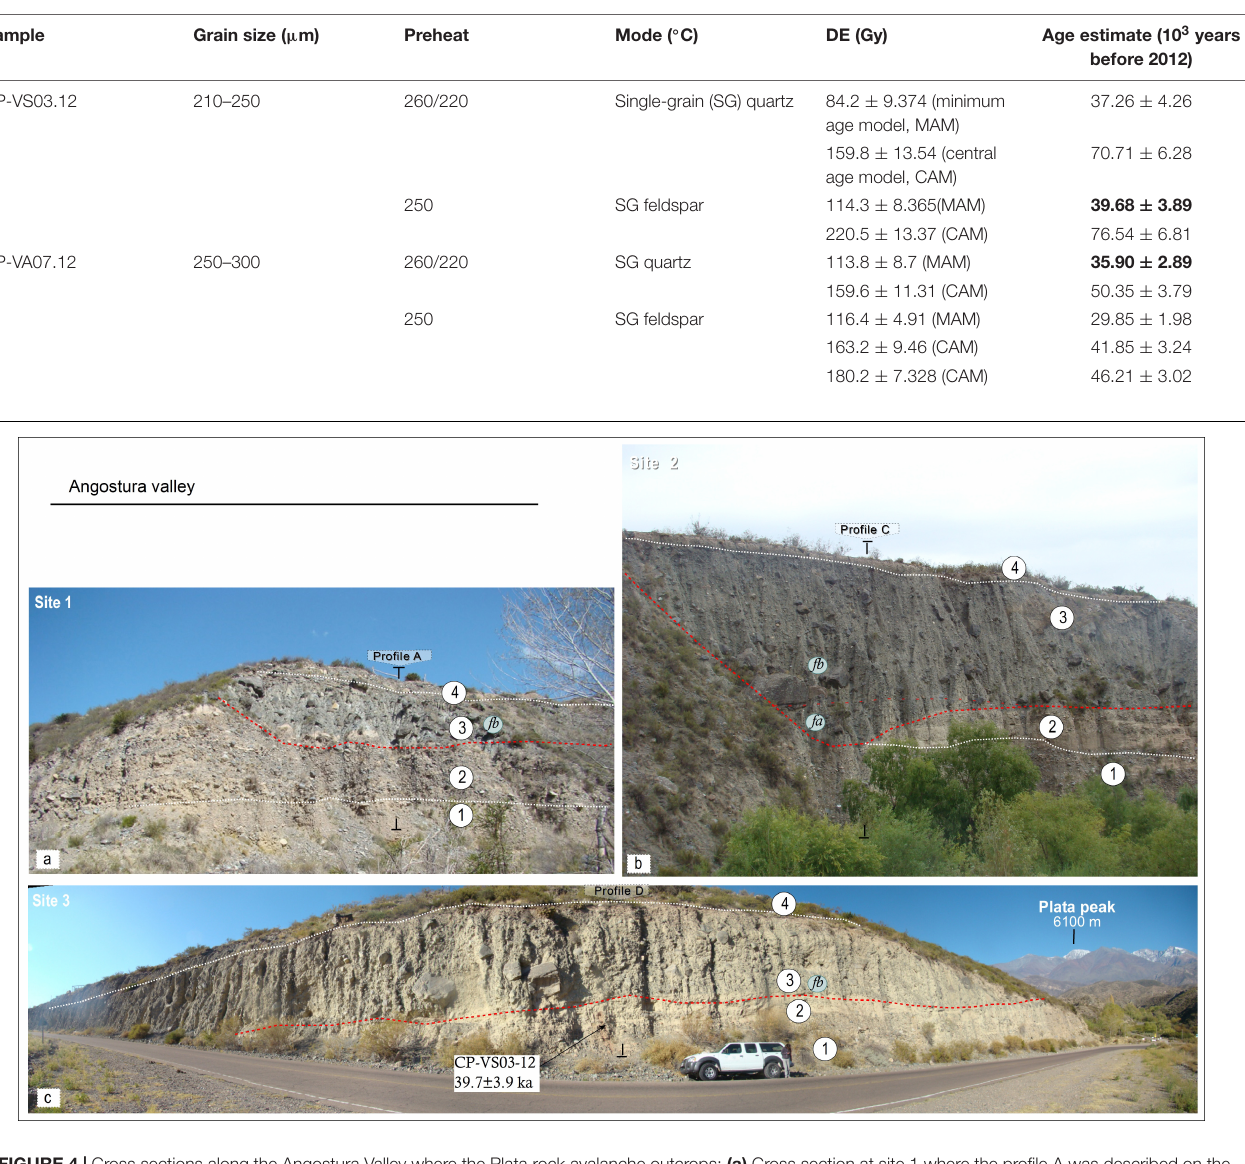
FIGURE 4 | Cross sections along the Angostura Valley where the Plata rock avalanche outcrops: (a) Cross section at site 1 where the profile A was described on the right margin of the Angostura valley. Units: 1. corresponds to basal fluvio-glacial deposits, 2. alluvial deposits, 3. the Plata rock avalanche, and 4. A 0.7 m thick- alluvial layer (see Figure 5 ). The profile B was described 300 m from profile A. (b) Cross section at site 2 where the profile C was described on the left margin of the Angostura valley. Units: 1. gravel alluvial deposits, 2. finer alluvial deposits, 3. the Plata rock avalanche with erosive basal contact, and 4. alluvial layer (see Figure 5 ). (c) Cross-section at site 3 just in front site 2 where the profile D was described on the right margin of the Angostura valley. Units: 1. gravel alluvial deposits, 2. finer alluvial deposits from where the sample CP.VS 03.12 was taken, 3. the Plata rock avalanche, and 4. alluvial layer (see Figure 5 ). Facies a (fa) and facies b ( fb ).